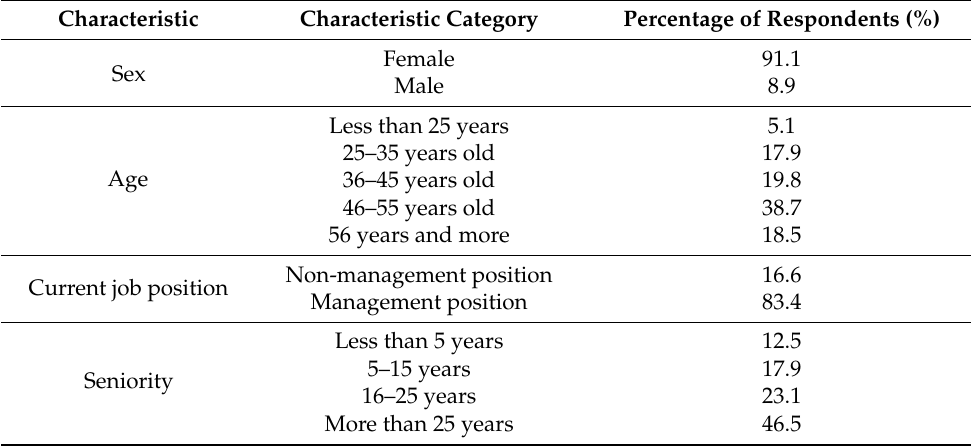
Table 1. Research sample—structure according to selected characteristics (N =